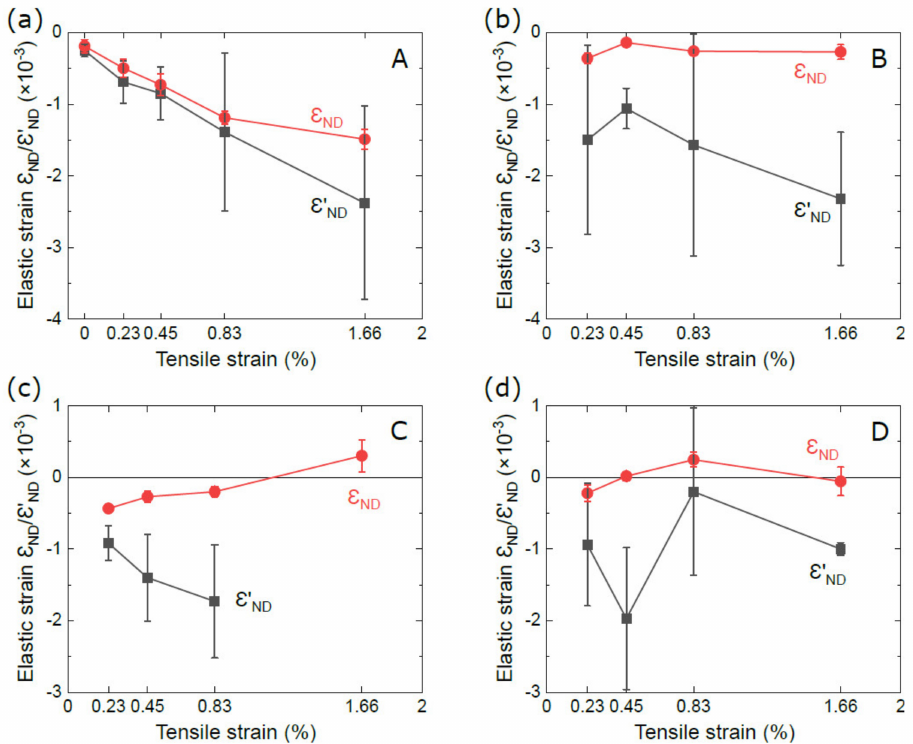
Figure 14. Average lattice strain ε ND and deviatoric strain ε (cid:48) ND (magnitudes large than 5 × 10 − 3 are discarded during averaging) in four Ti grains below the Al layer before and after tensile deformation to different strains. ( a ) Grain A; ( b ) grain B; ( c ) grain C; ( d ) grain D. The error bars show standard deviations. The 0.2% offset yield point strain for Ti is about